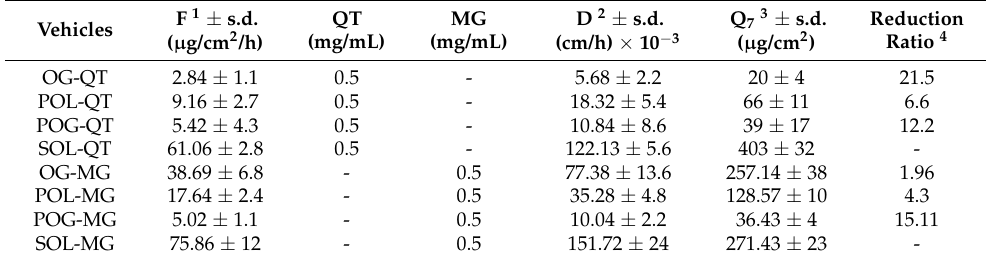
Table 3. Diffusion parameters of the indicated formulations. Vehicles